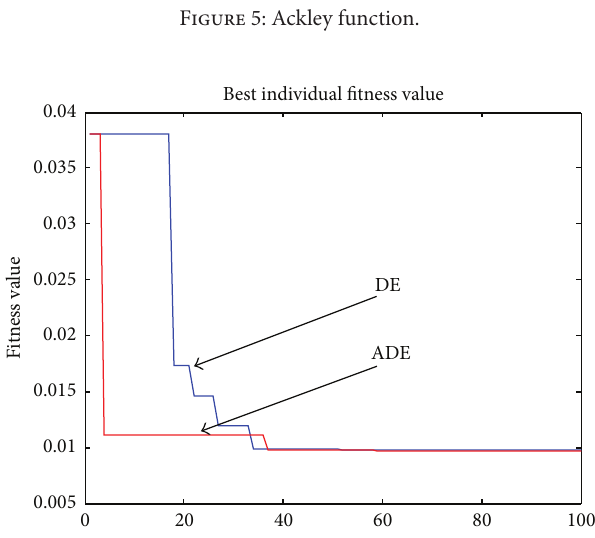
Figure 3: Rastrigin function.